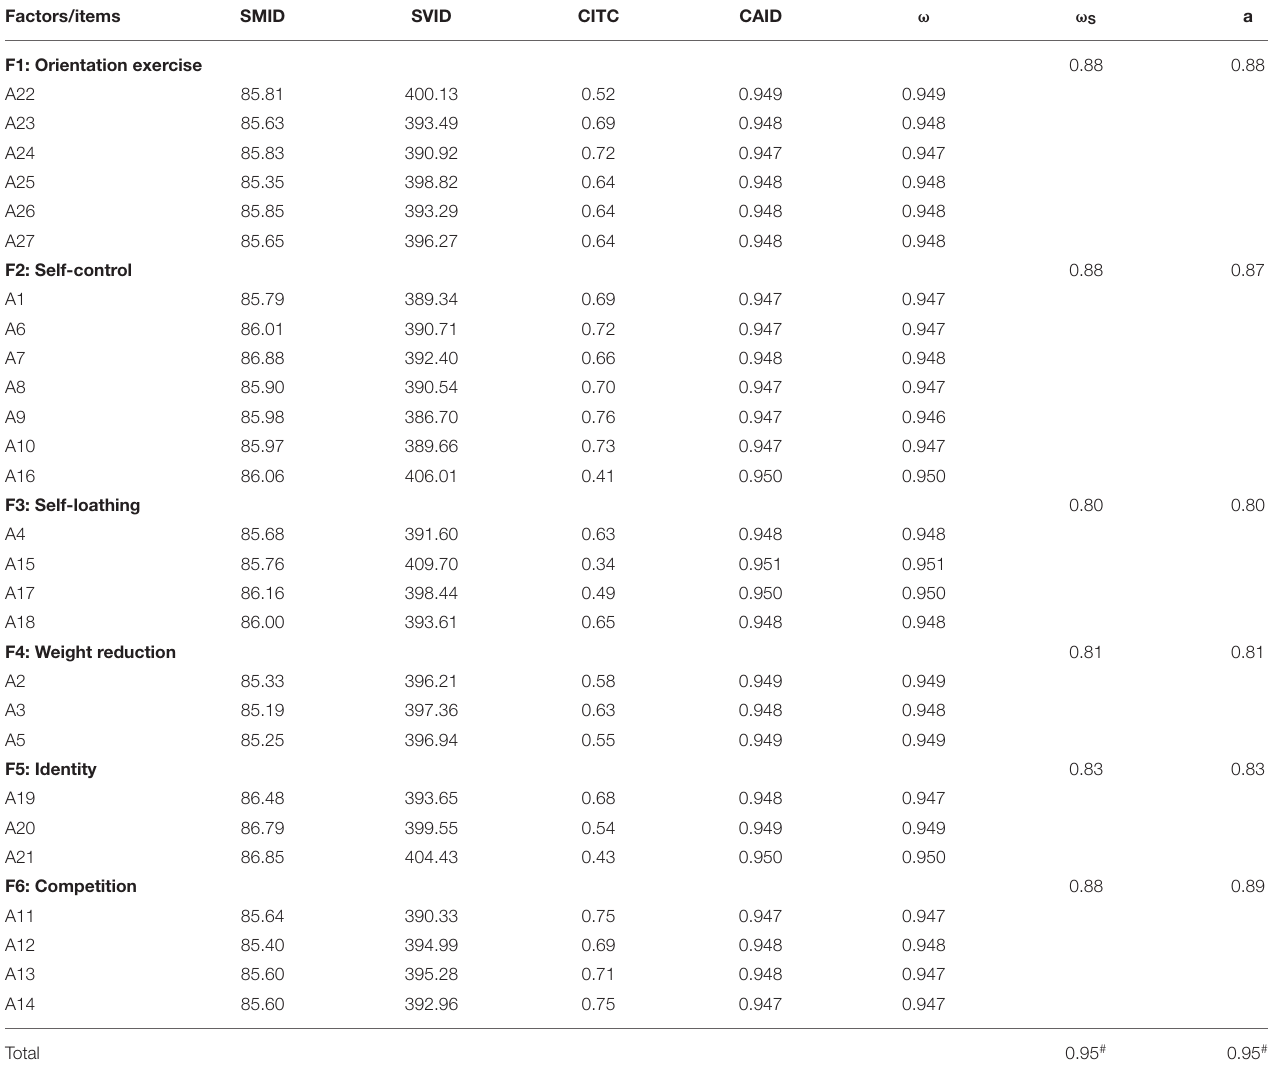
TABLE 3 | Item-total statistics.